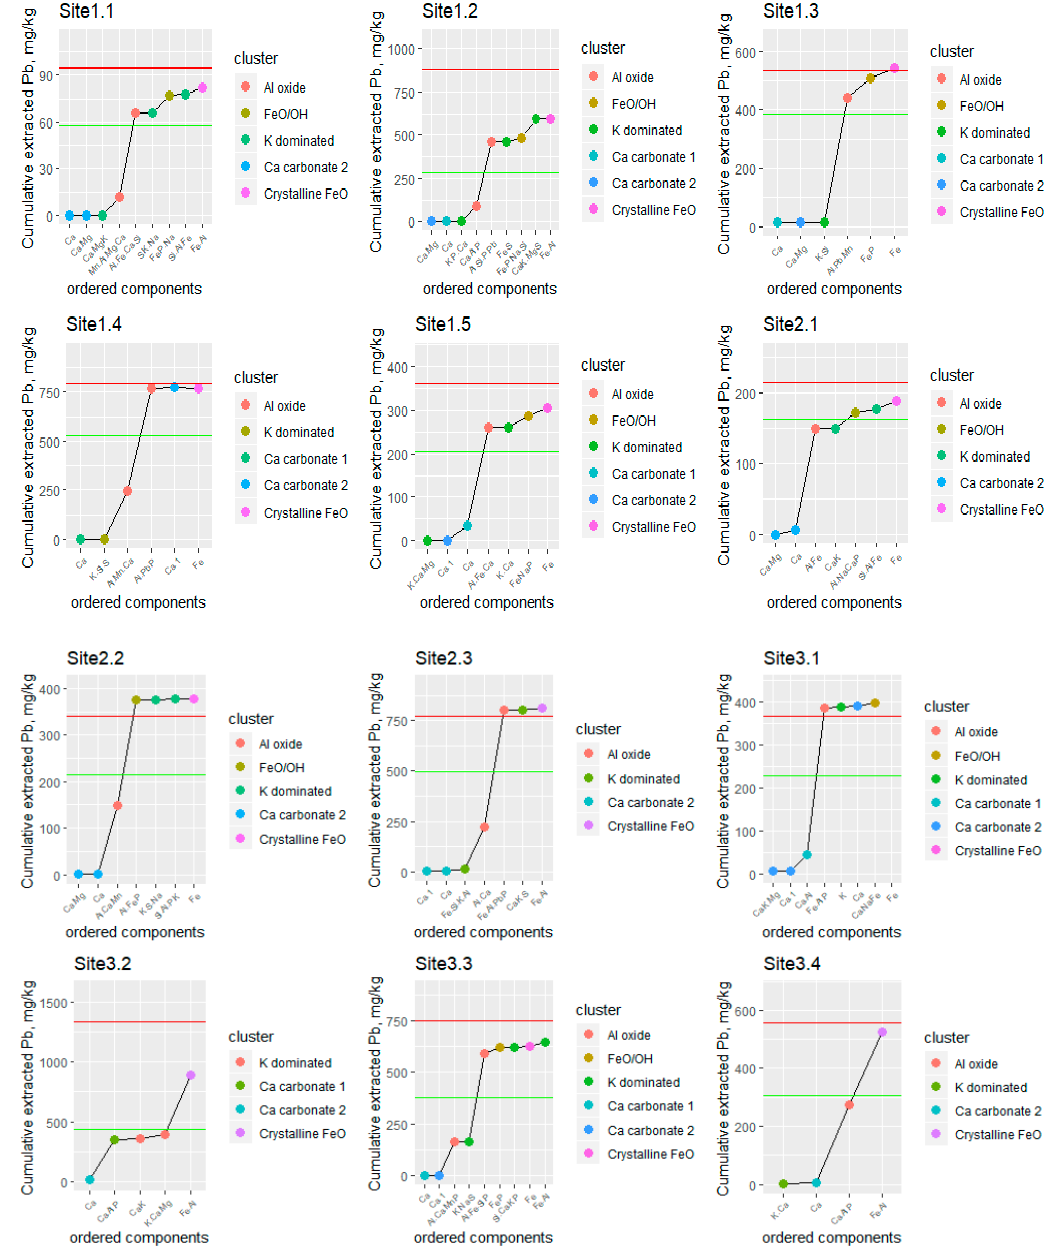
Figure 12. Comparison of cumulative CISED extracted Pb and the bioaccessible and total Pb in the soils. The solid red line indicates the total Pb content and the solid green line indicates the bioaccessible Pb content.